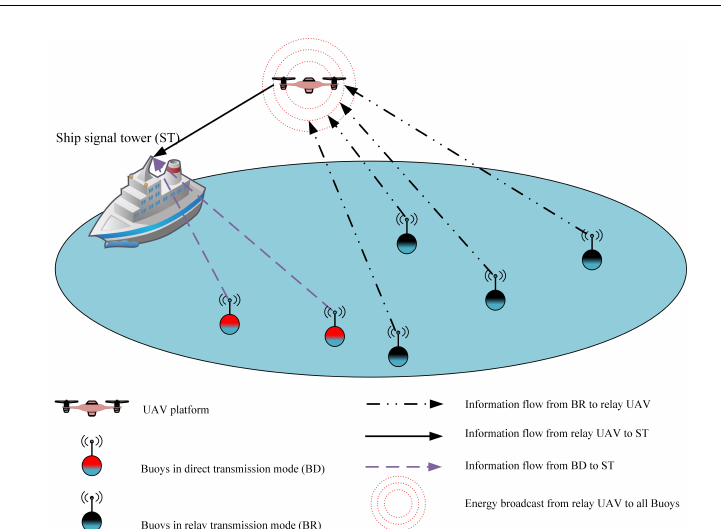
Figure 1. Unmanned aerial vehicle (UAV)-enabled wireless powered relay network (U-WPRN) system model with relay